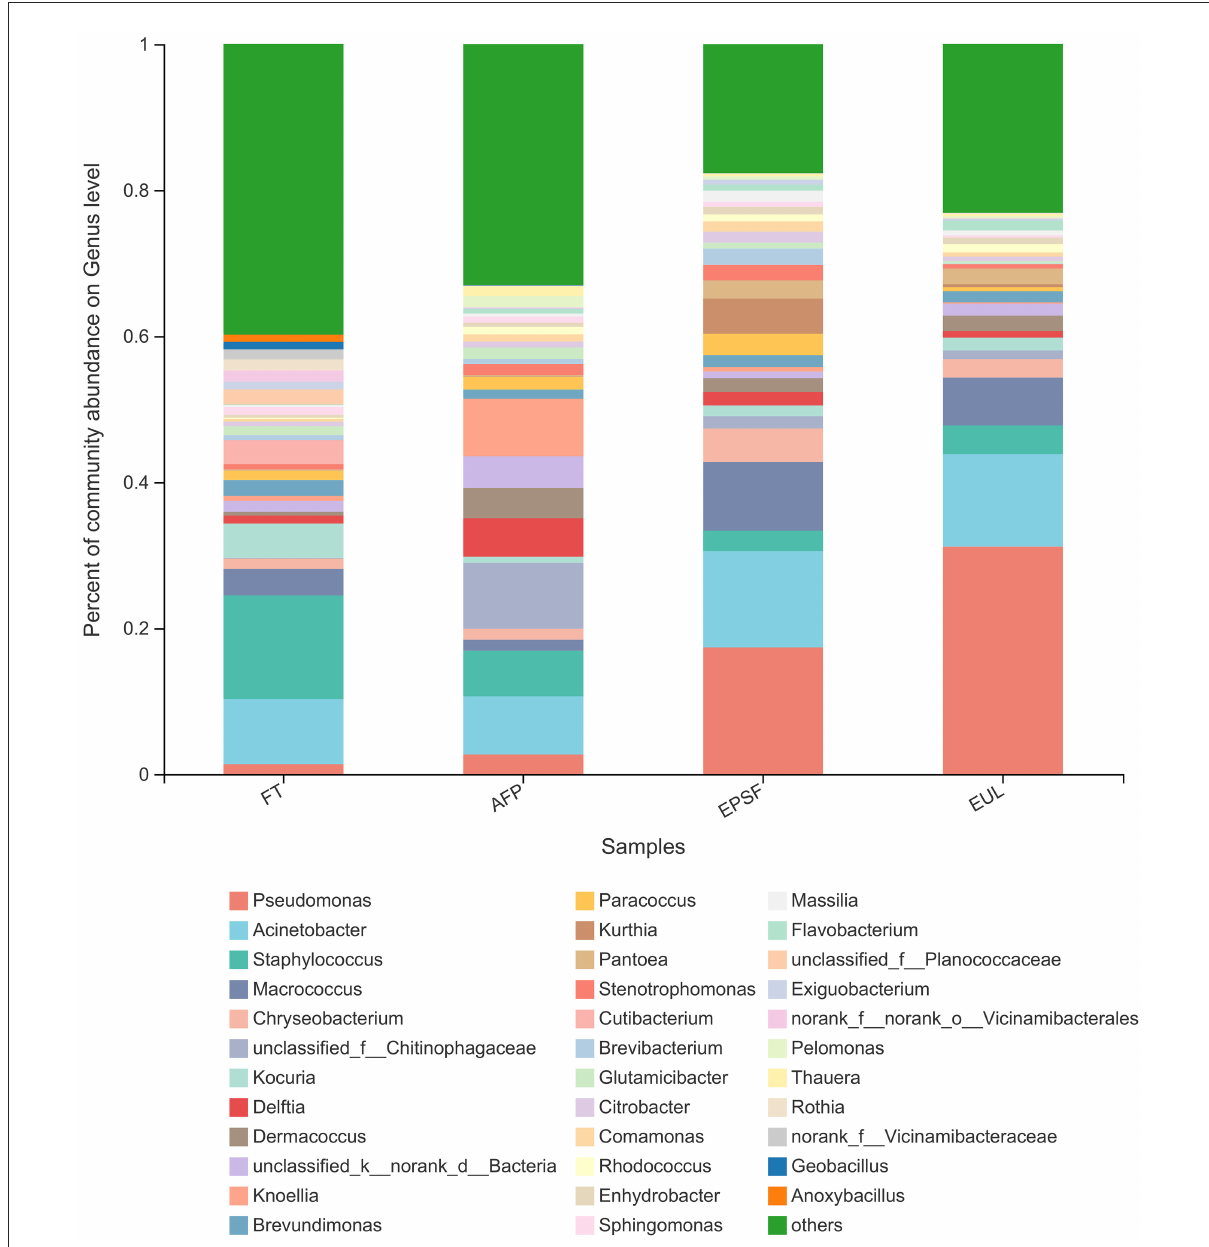
FIGURE6 Changes in microbial community structure in bigeye tuna muscle with various logistics packaging boxes at the genus level. FT, fresh tuna; EUL, European logistics; EPSF, expanded polystyrene foam; AFP, aluminum foil